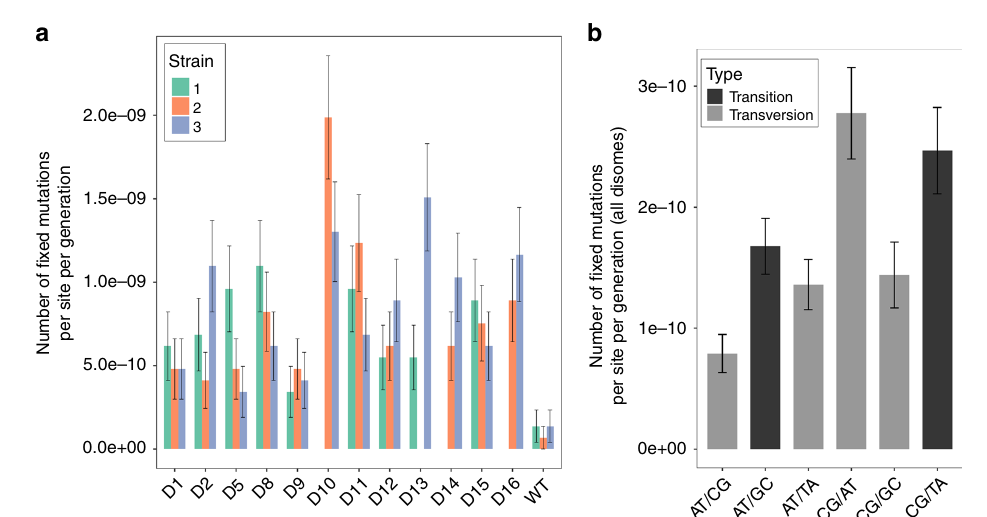
Fig. 4 De novo mutations during experimental evolution. a Number of de novo mutations per site per generation fi xed during experimental evolution of disomes and WT. b Apparent mutation rates split by mutation type. Error bars represents standard errors computed as in ref. 74 . Source data for the number of mutations and the rate are provided as a source data fi